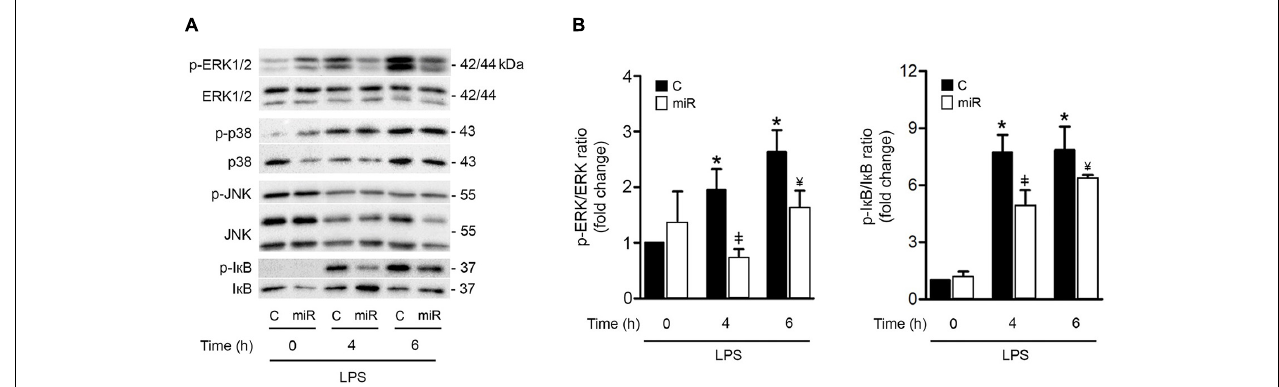
FIGURE 4 | Modulation of ERK1/2 and NF- κ B activation by miR-335. BV2 cells were transfected with a pre-miR-335 or pre-NC for 24 h and then stimulated with LPS for 4 or 6 h. Representative immunoblots for p-ERK/ERK, p-JNK/JNK, p-p38/p38, and p-I κ B/I κ B ratios (A) and densitometric analysis of p-ERK/ERK and p-I κ B/I κ B ratios (B) are presented. Results are presented as mean ± SEM of three independent experiments. * p < 0.0.5 vs. C 0 h; } p < 0.05 vs. LPS 4 h; ¥ p < 0.05 vs. LPS 6